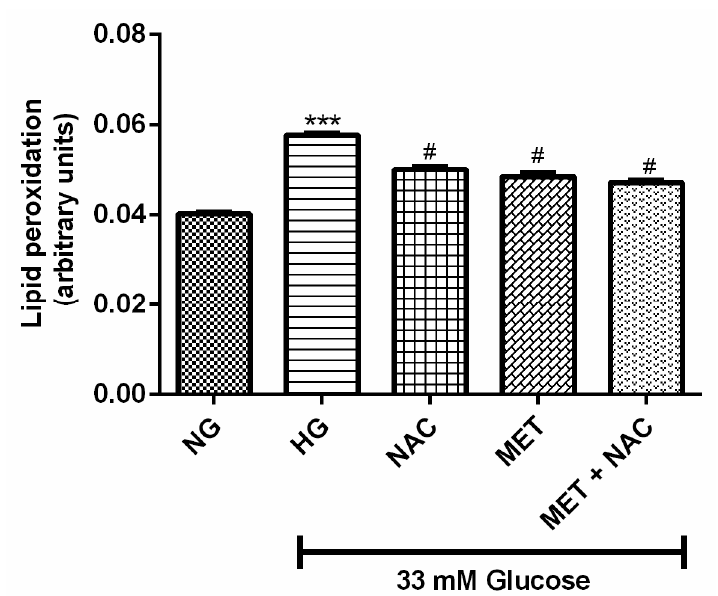
Figure 5. The combination e ff ect of Metformin (MET) and N-acetylcysteine (NAC) on high glucose-induced lipid peroxidation. Malondialdehyde (MDA) formation is a measurement of lipid peroxidation. H9c2 cardiomyoblasts were cultured in high glucose (HG; 33 mM) for 24 h. Cells were then co-treated with NAC (1 mM), metformin (MET) (1 µ M) and a combination of MET + NAC. Data are presented as the mean ± SEM of 3 distinct biological experiments with each experiment having 3 technical repeats ( n = 9). Significance is depicted as *** p ≤ 0.001 versus NG control, # p < 0.05, versus HG control.